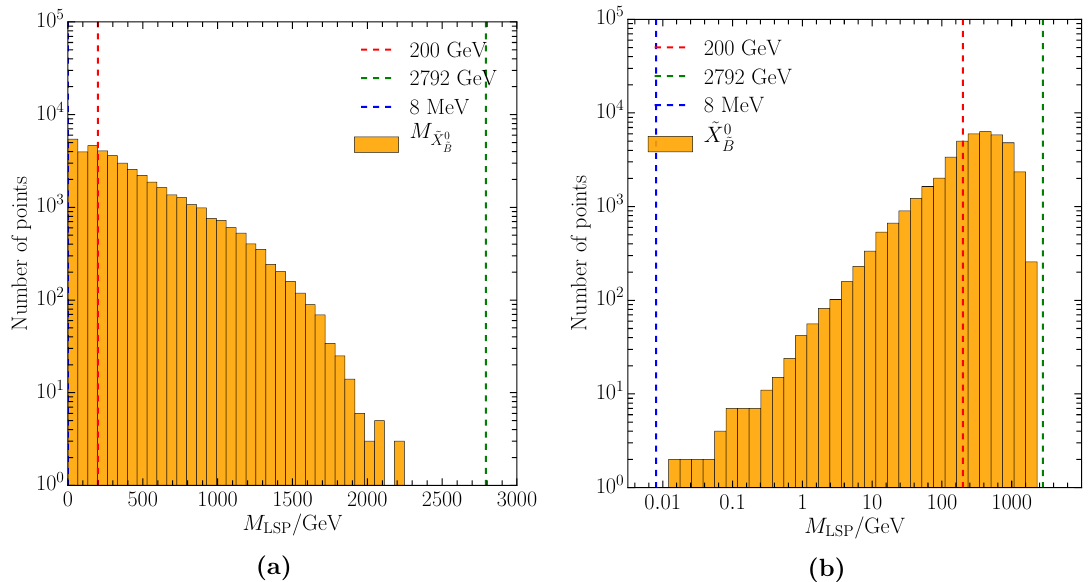
Figure 3. The distribution of the Bino neutralino LSP masses for the 42,039 valid black points, shown with linear (a) and logarithmic (b) mass scales. The masses range from 8 MeV to 2792 GeV. Each of the boundary masses occurs only once out of the 42,039 valid points and, hence, they cannot be seen in the